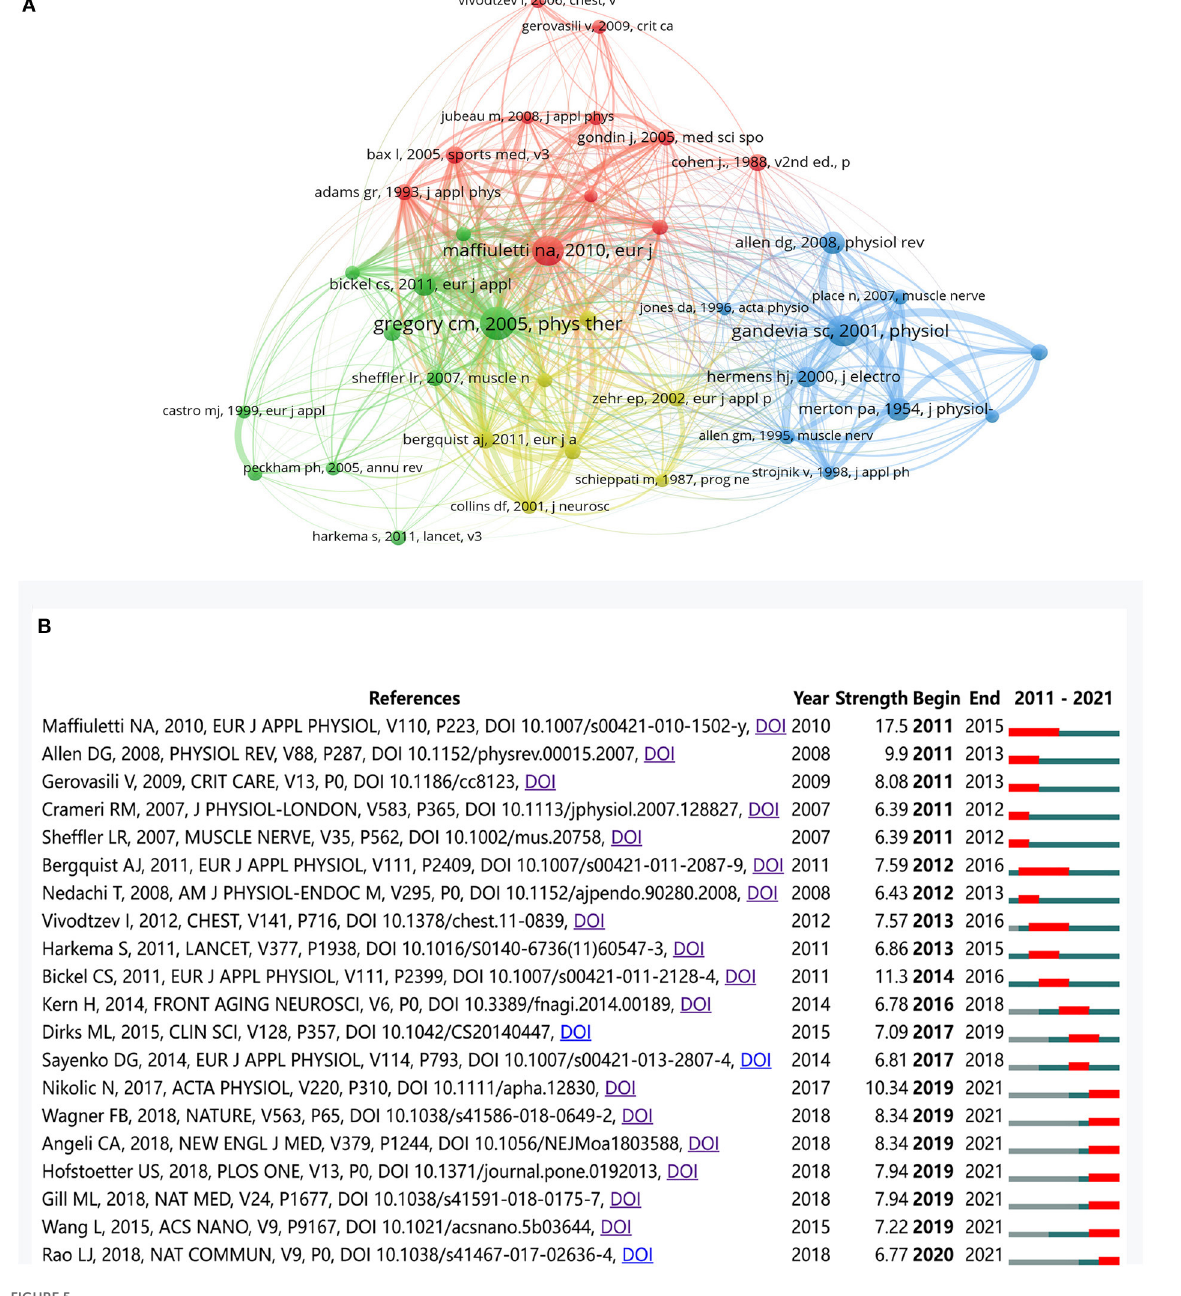
FIGURE5 (A) The co-citation network map of references. (B) The top 20 references with the strongest citation bursts. The red segment denoted the burst duration of a reference.